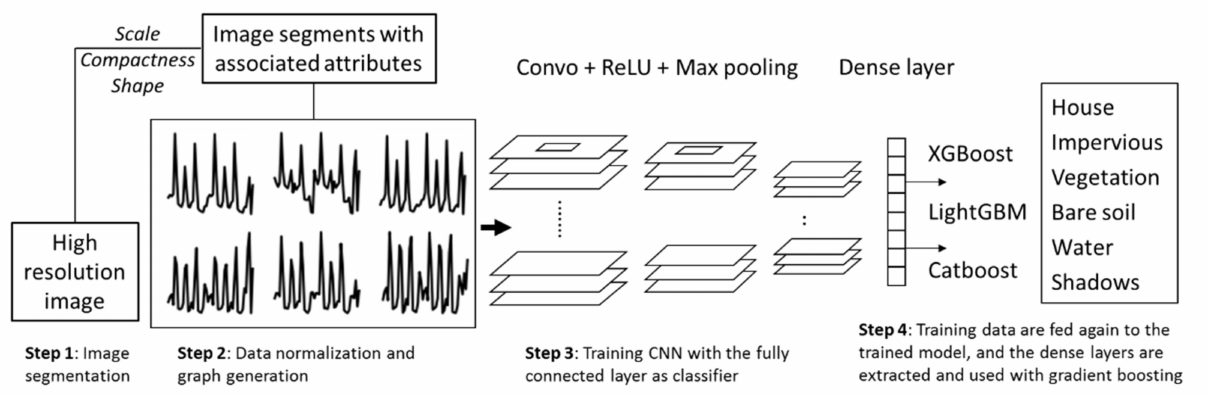
Figure 3. Object-based convolutional neural network with gradient boosting algorithms.